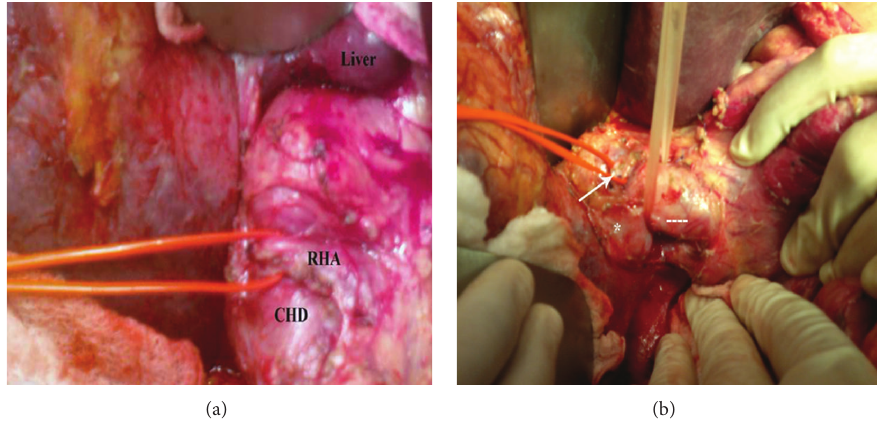
Figure 1: (a) RHA (red lacks) crossing anteriorly to the CHD and compressing it. RHA: right hepatic artery; CHD: hepatic duct. (b) Lateral view of the hepaticoduodenal ligament. The RHA (white arrow) crossing anteriorly to the dilated CHD (dashed line). Asterisk corresponds to the dilated right hepatic duct.